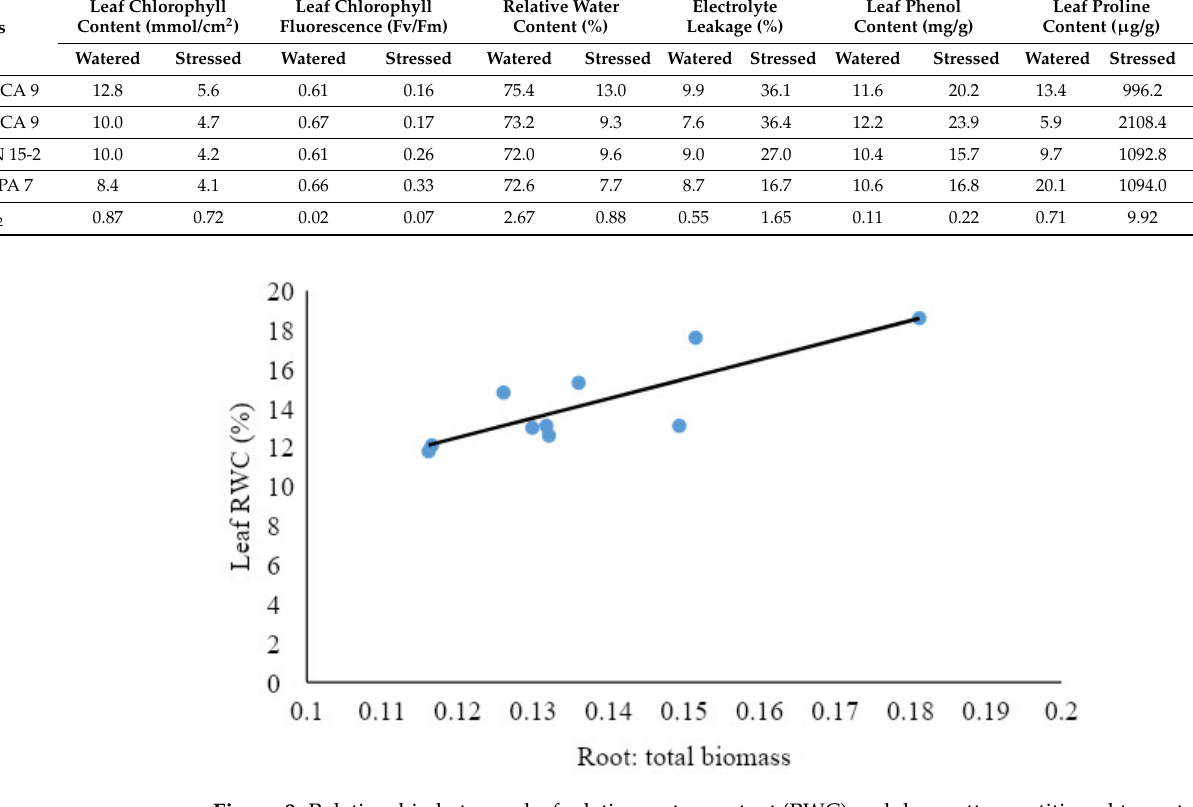
Table 6. Effects of watering regime and potassium levels on some physiological functions of four cocoa varieties in exper- iment 1 evaluated in a gauzehouse facility.